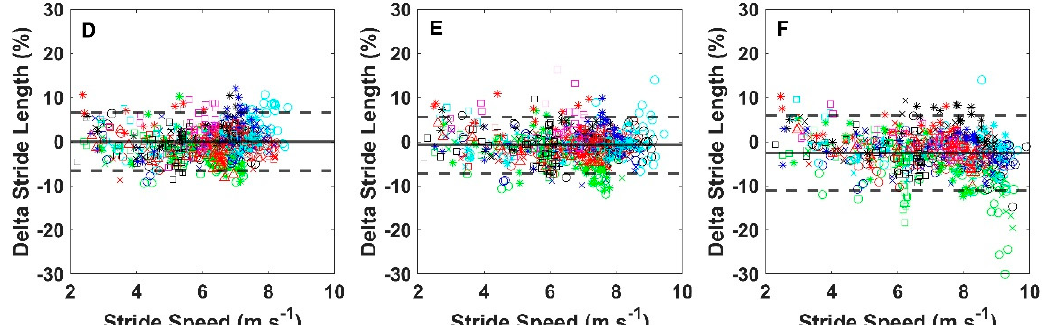
Figure 3. Typical examples of SL of both feet (rear foot at the start in red, front foot in blue) as a function of time for participant nos. 3 ( A ) and no. 9 ( B ) at 100% effort reaching maximal speeds of 9.17 and 8.95 m · s − 1 , respectively. Note that SLs from video (open circles) and IMUs (crosses) are very similar for both feet in ( A ), while in the other participant, the IMUs underestimated SL compared to the reference for the front foot only ( B ). ( C ) depicts the delta values (IMU–video) expressed as a percentage of video SL for all strides as a function of the video reference. Each symbol represents the data of a single participant. Delta values from sprints executed at 60, 80, and 100% effort, respectively, are shown ( D – F ) as a function of stride speed. Note that already at 60% effort, most strides were executed at a speed >5 m · s − 1 . The continuous lines represent the biases and the dashed lines, the limits of